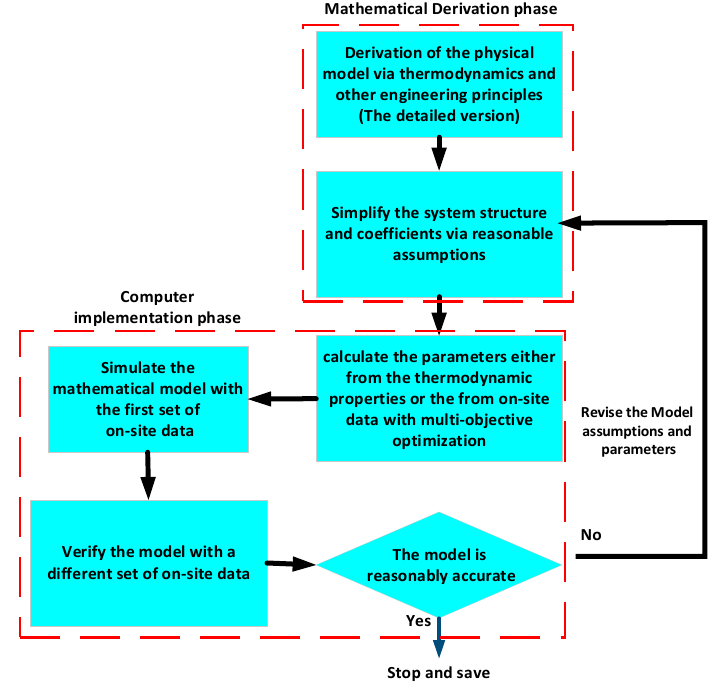
Figure 3. The general systematic approach to develop physical models or mathematical models that are rooted from system physics.